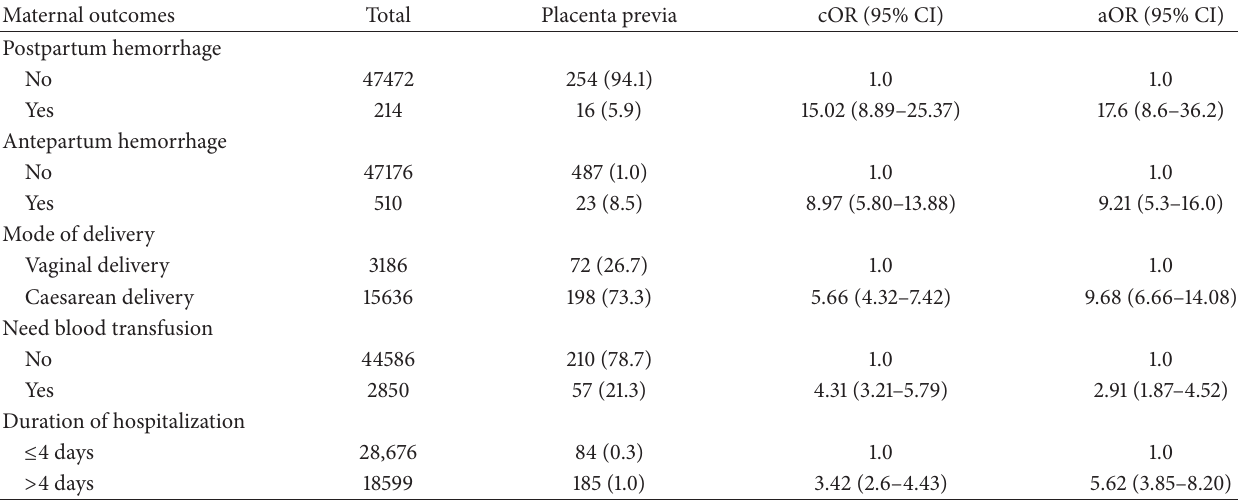
Table 3: Logistic regression for maternal outcomes associated with placenta previa ( 𝑁 = 47 ,686).